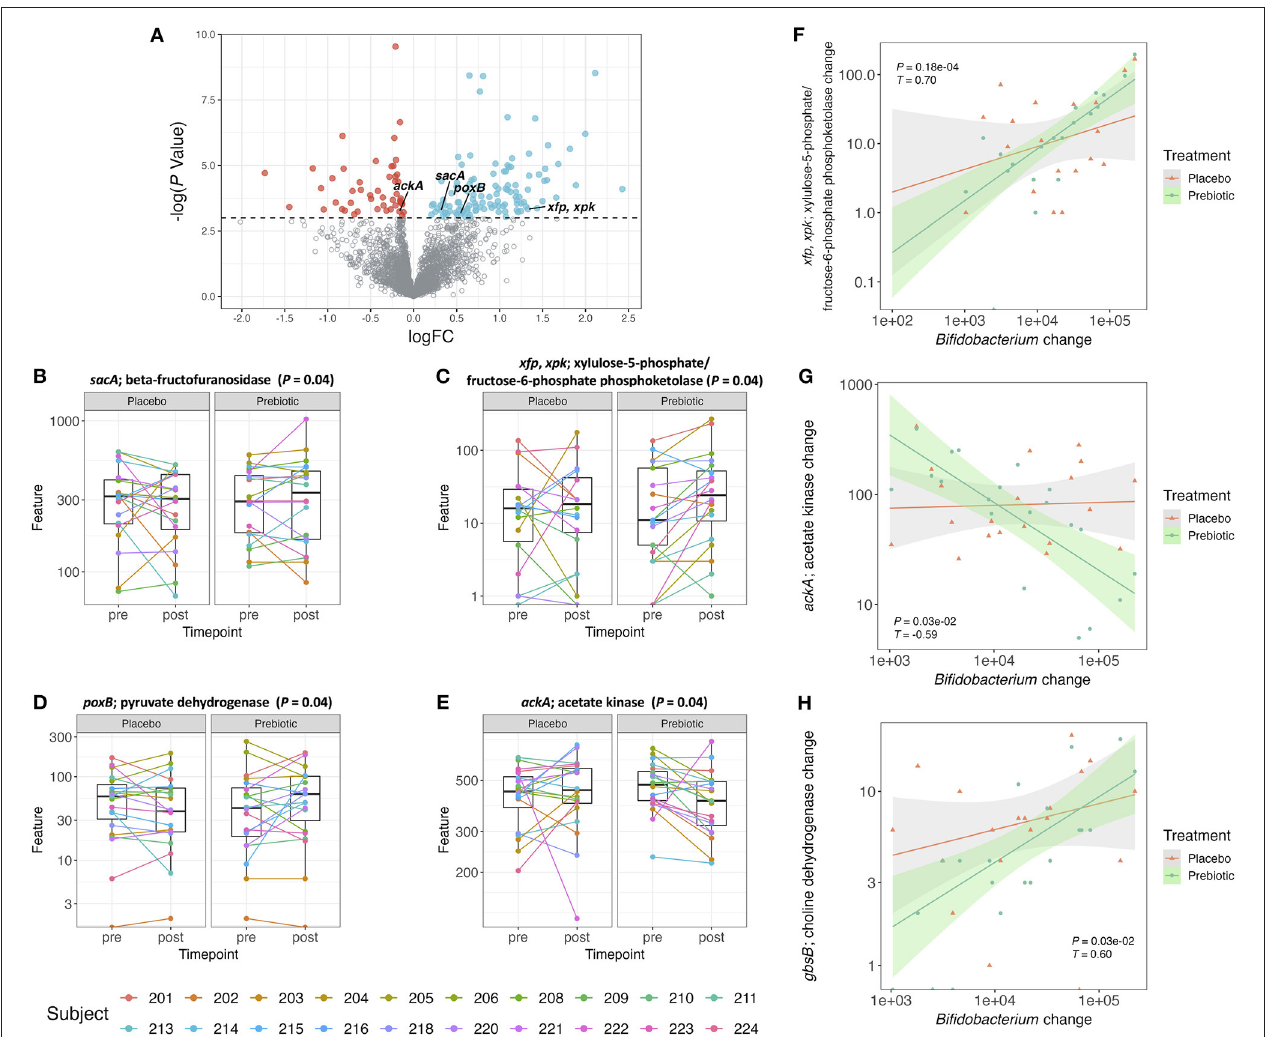
FIGURE 3 | (A) Volcano plot of all detected genes. Genes with a logFC (post–pre treatment) > 0 and a –log( P -value) > 0.05 are colored blue and genes with a logFC < 0 and a –log( P -value) > 0.05 are colored red. All the other genes are colored gray. (B–E) Box plot of gene counts pre- and post-treatment with placebo or prebiotic ( P ≤ 0.05, unadjusted). (F–H) Correlation plot of changes (post–pre) in Bifidobacterium abundance against changes (post–pre) in gene counts for both placebo and prebiotic in 20 subjects (prebiotic: P ≤ 0.05, adjusted, Kendall T